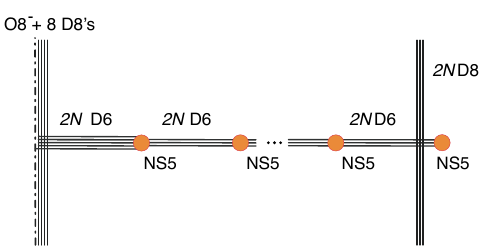
Figure 48 . 6d brane con(cid:12)guration for the [8] quiver theory.